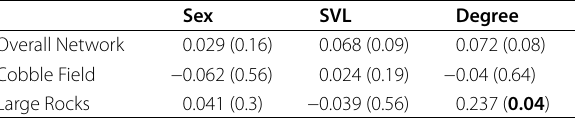
Table 3 Assortativity values for individuals included in social network on site 1